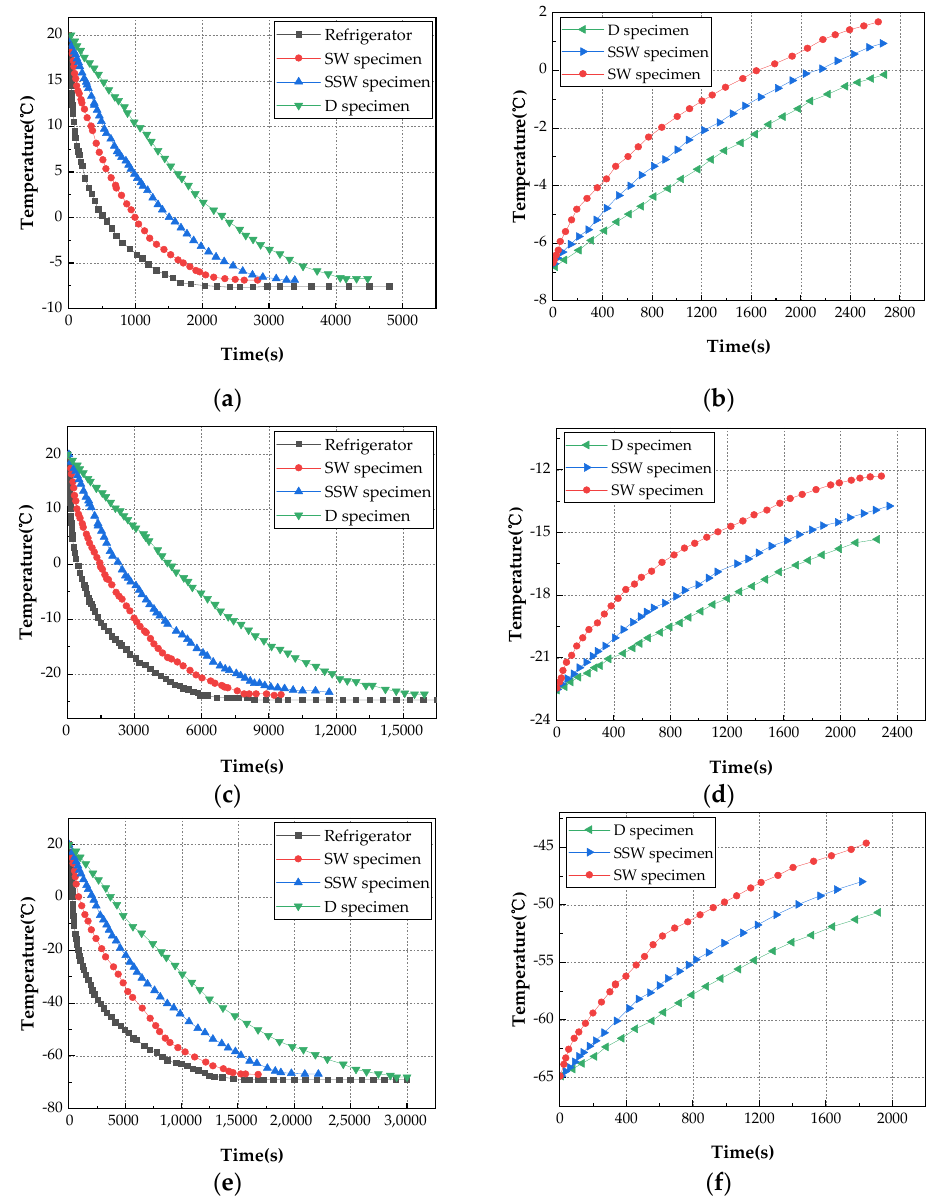
Figure 7. Heating and cooling curves of SW, SWW, and D specimens at 0, − 20, and − 60 °C; ( a ) 0 °C cooling curve; ( b ) 0 °C heating curve; ( c ) − 20 °C cooling curve; ( d ) − 20 °C heating curve; ( e ) − 60 °C cooling curve; ( f ) − 60 °C heating curve.